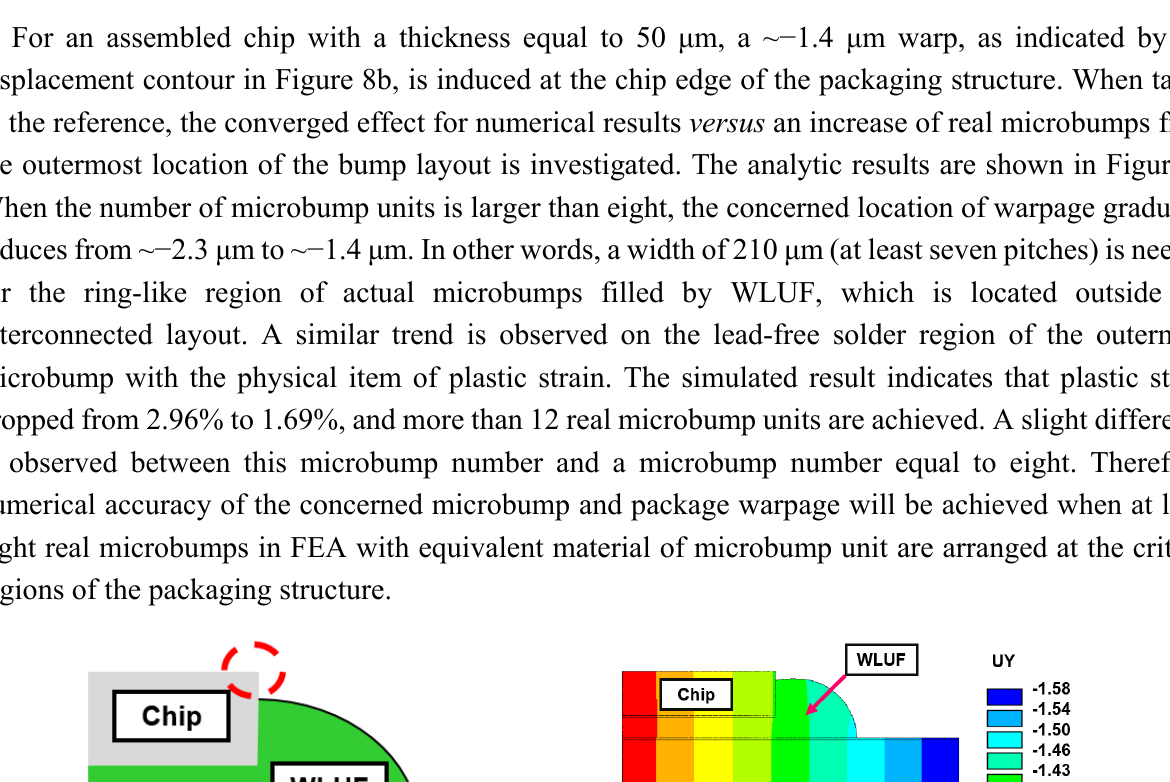
Figure 7. Temperature-dependent stress-strain curve of lead-free solder.